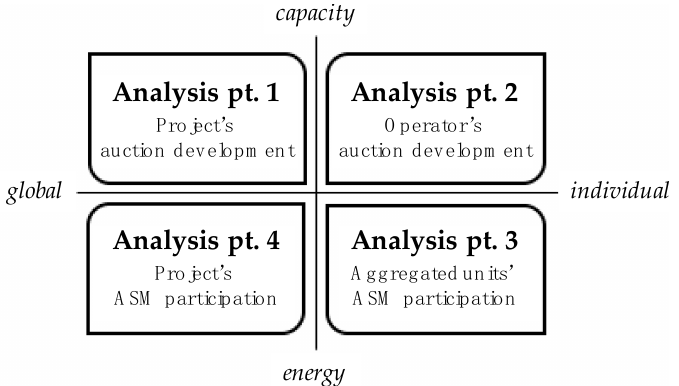
Figure 2. The four quadrants of the UVAM (Unità Virtuali Abilitate Miste, i.e., virtually aggre- gated mixed units) project analysis.